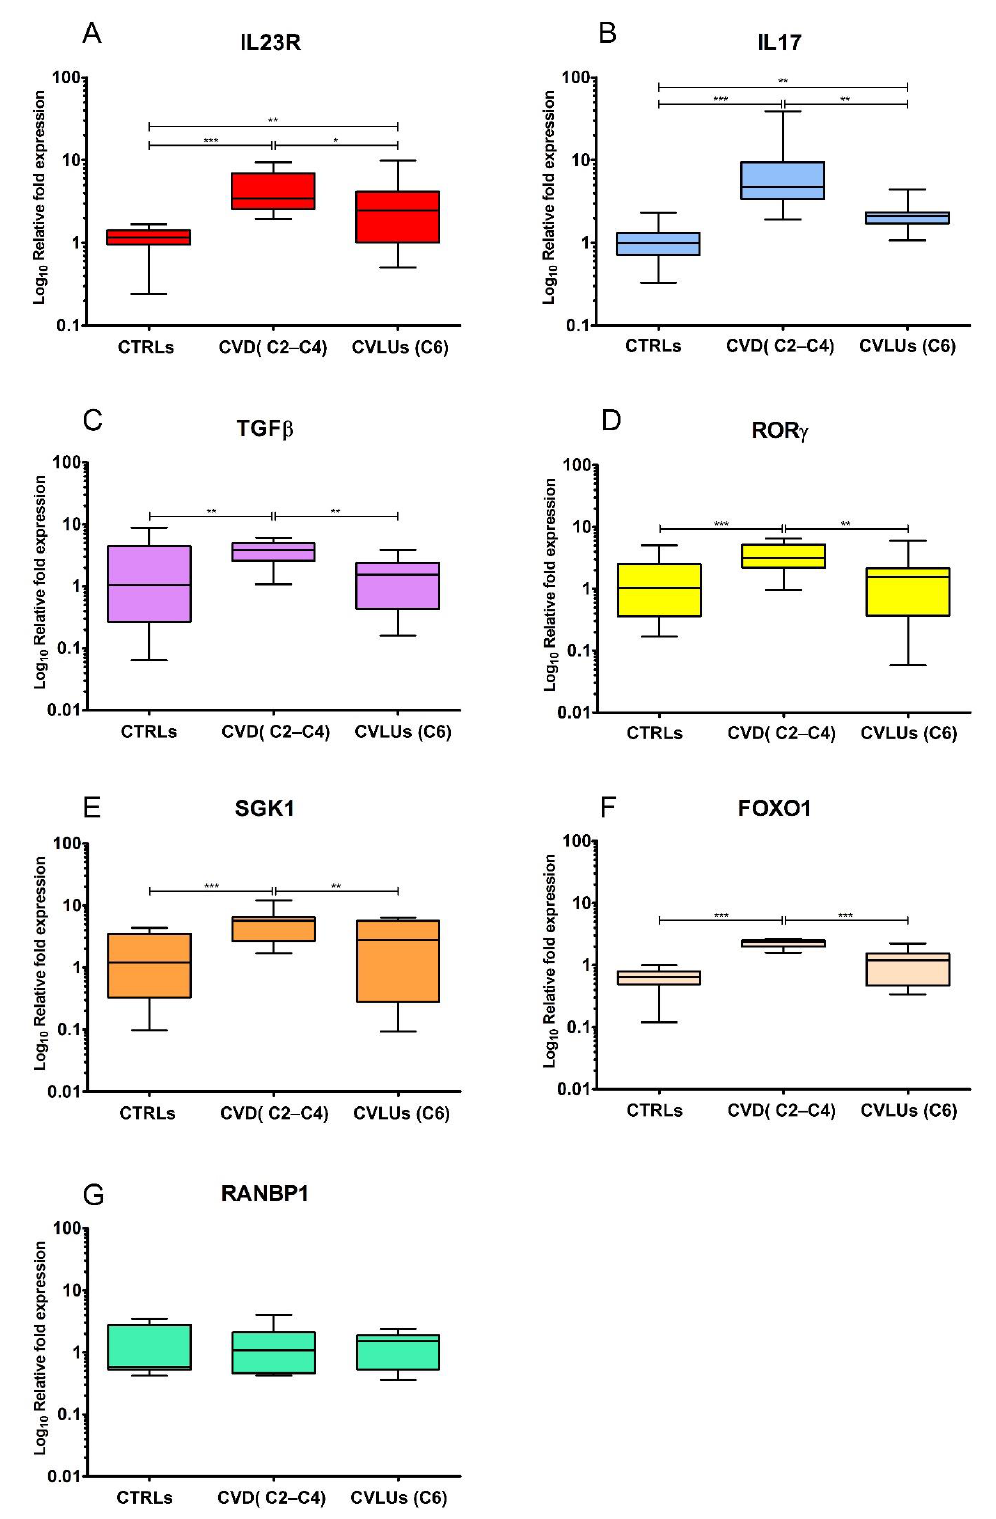
Figure 1. qRT-PCR analysis of IL23R ( A ), IL17A ( B ), TGFB ( C ), RORG ( D ), SGK1 ( E ), FOXO1 ( F ), and RANBP1 ( G ) in PBMCs of the healthy controls, the ( n = 8), CVD ( n = 8), and CVLUs ( n = 7) patients. The results, normalized to HPRT1, are represented as a relative fold expression (Log10 scale) in the whisker plots from minimum (Q0) to maximum (Q4). Statistical significance is indicated at the top of the graph. * p ≤ 0.05; ** p ≤ 0.01; *** p ≤